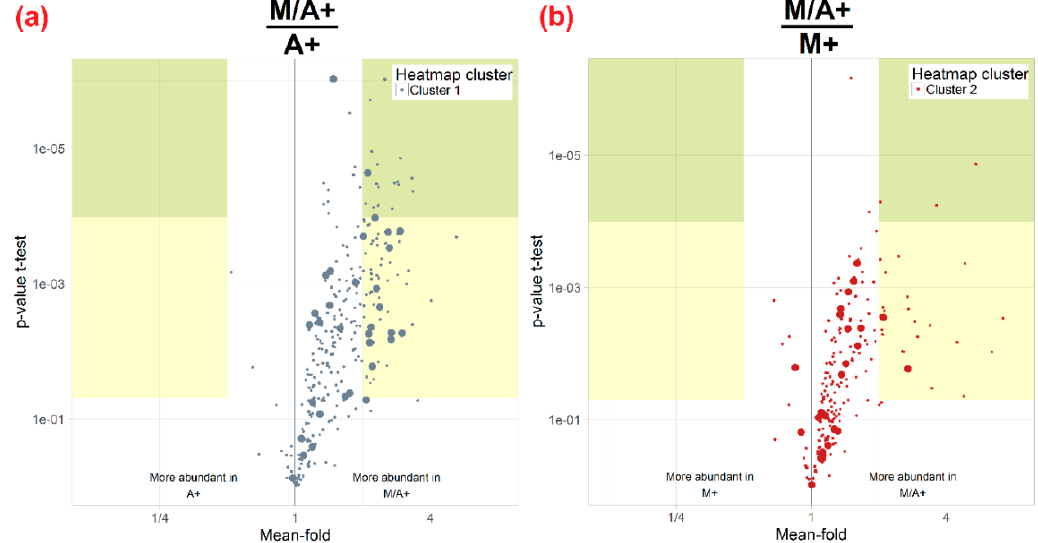
Figure 6. ( a ) Volcano plot, illustrating the abundance of metabolites of cluster 1 (i.e., more efficiently extracted by acidified acetonitrile M+ compared to A+, grey dots) in extracts of the three-solvent mixture M/A+ relative to their abundance in A+-derived extracts; ( b ) Ratios of metabolite abundance and p -values of cluster 2 metabolites (primarily extracted by A+, red) measured in M/A+ extracts relative to their abundance after use of M+.